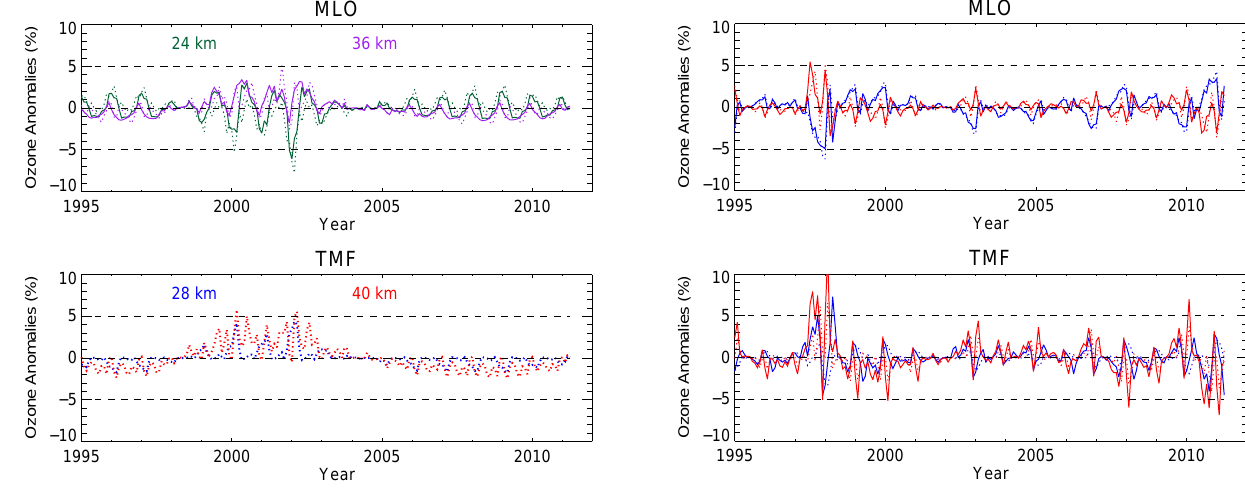
Fig. 8. Ozone response to SC 11 perturbations at different altitude over MLO and TMF. Lidar responses are solid lines and satellite are dotted lines.